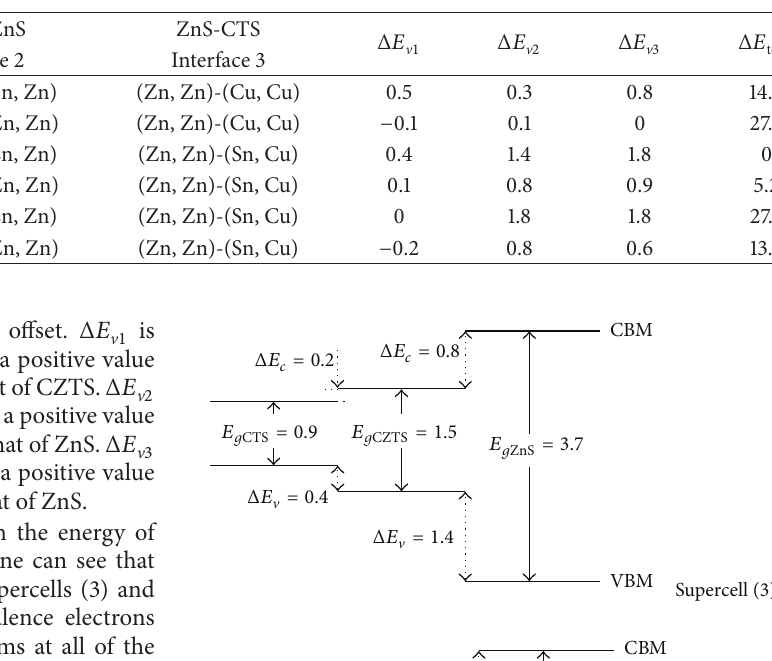
Table 1: Valence band offsets (eV) at each interface and the total energies (meV/atom) for six supercells with different interface layer atoms. The interface between CTS and CZTS is interface 1, interface between CZTS and ZnS is interface 2, and interface between ZnS and CTS is interface 3.